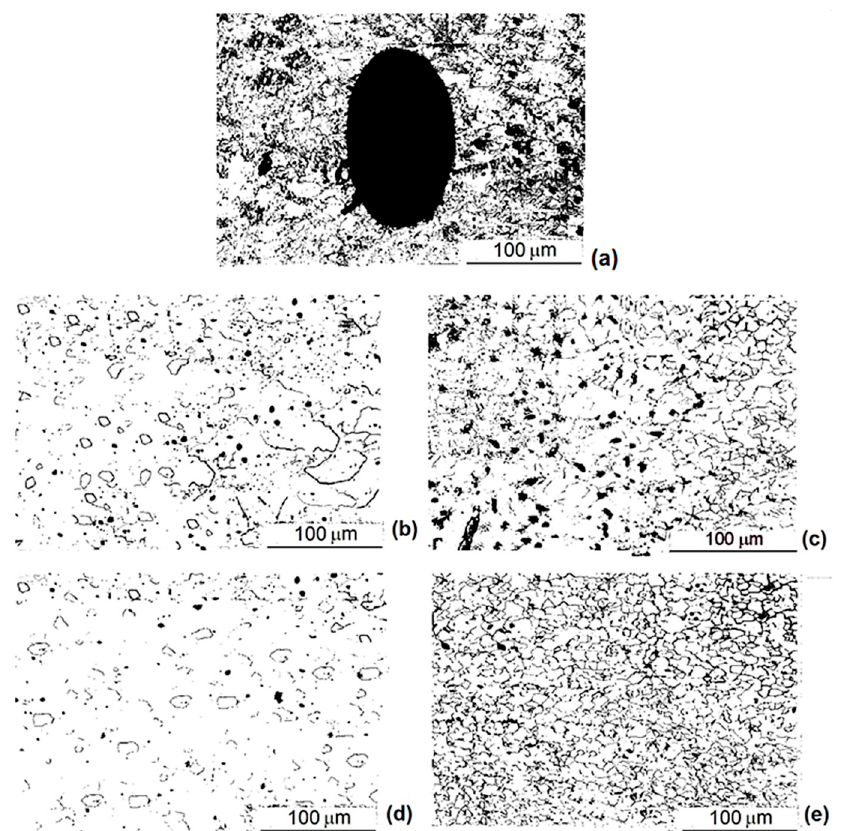
Figure 3. Microstructure of TWB1. ( a ) Fusion zone (FZ) (DX54D+Z/DX53D+Z); ( b ) Heat-affected zone